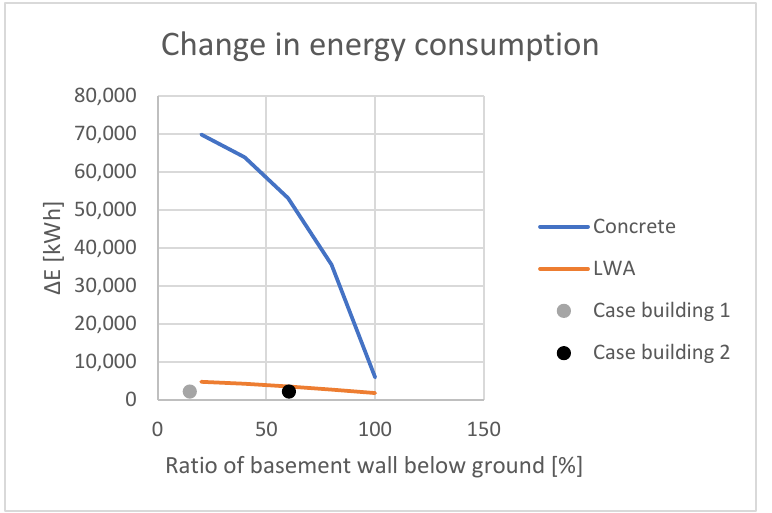
Figure 4. Difference in energy loss for basement with concrete and light-weight aggregate walls, compared to no upgrade.